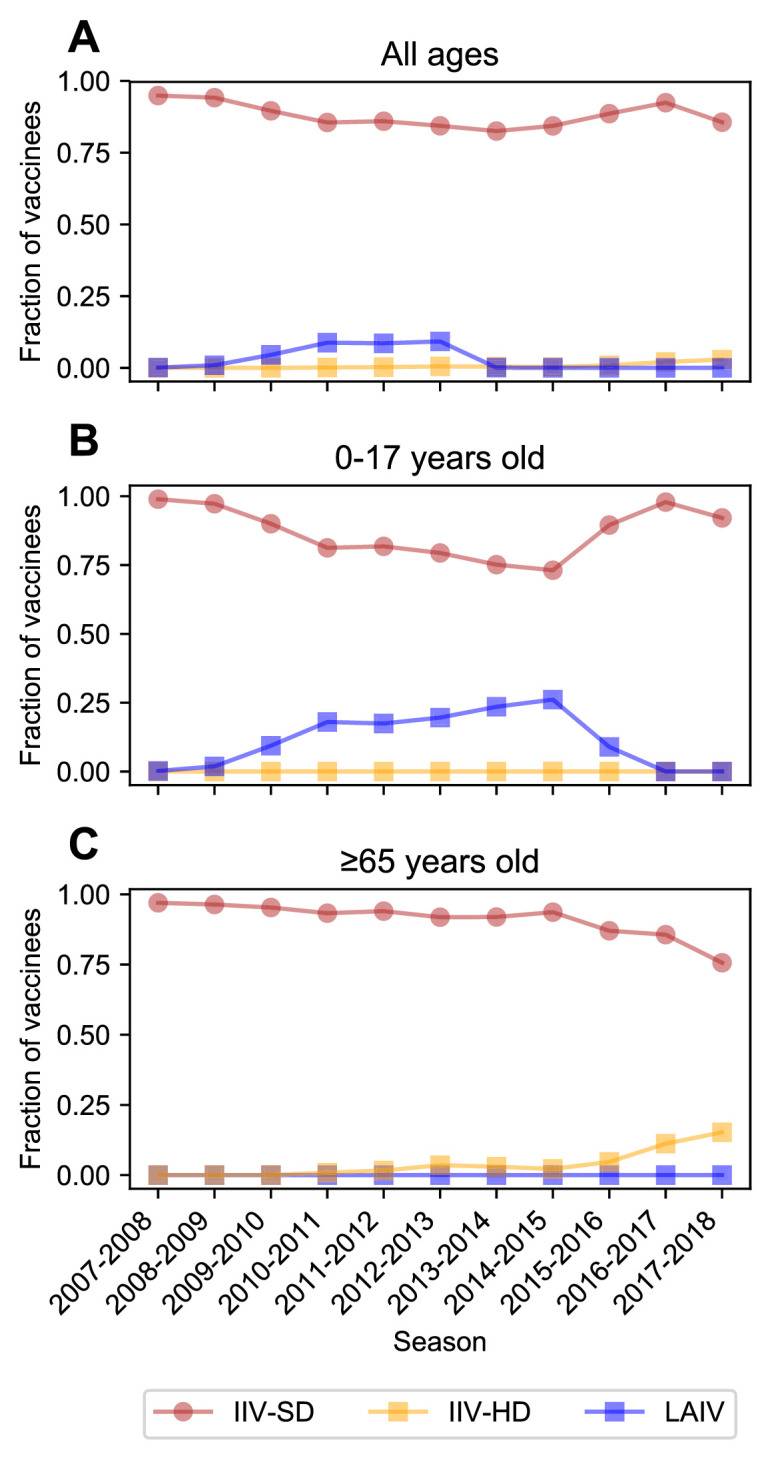
Vaccine type received.Most vaccinated study participants received the inactivated influenza vaccine. The fraction of vaccinated people who received the standard-dose inactivated influenza vaccine (IIV-SD), the high-dose inactivated influenza vaccine (IIV-HD), or the live attenuated influenza vaccine (LAIV) is shown for all participants (A), children < 18 years old (B), and adults ≥65 years old (C).